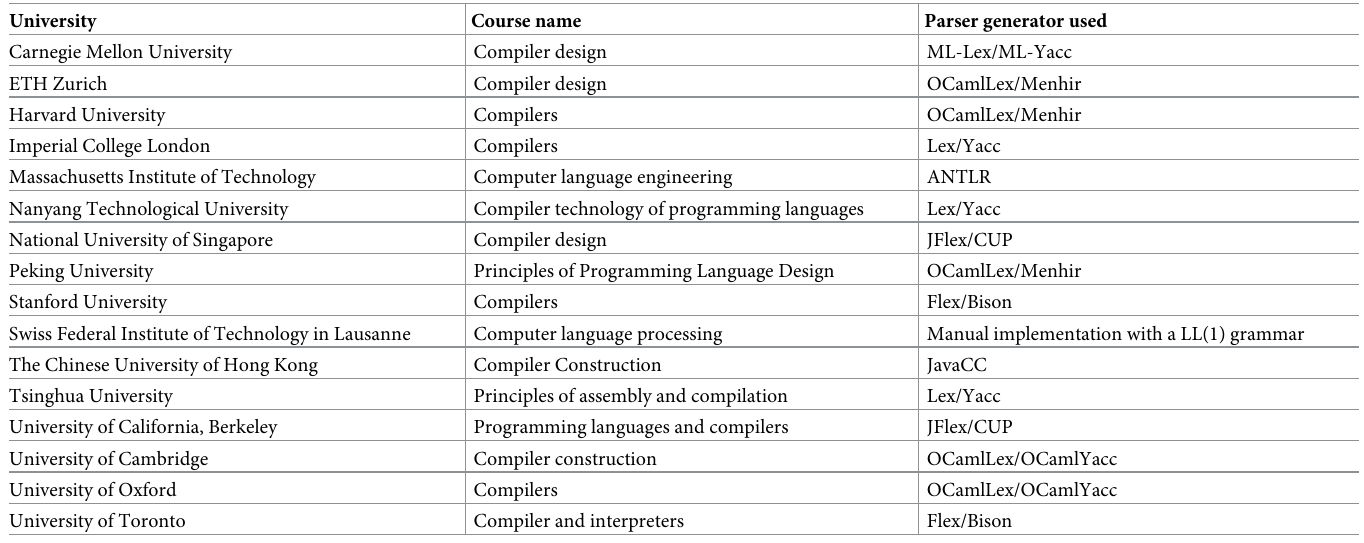
Table 1. Parser generation tools used in the compiler courses of the top 10 universities according to Shanghai Consultancy [6], Quacquarelli Symonds [7], Times Higher Education [8], and US News [9]